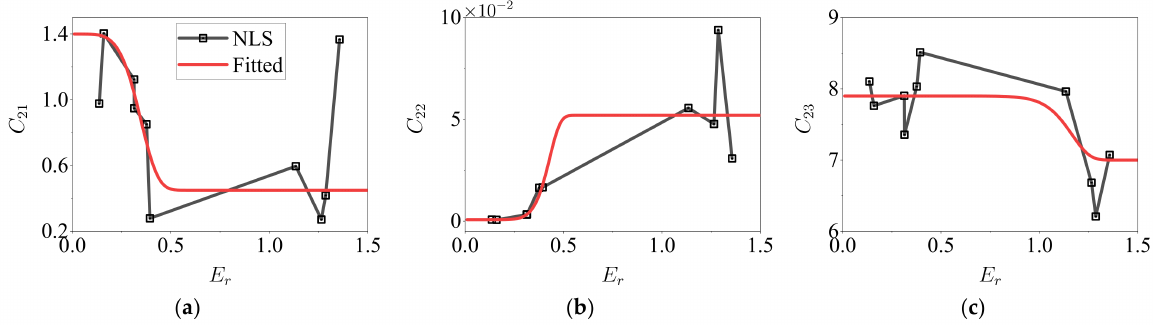
Figure 18. General parameters for β , ( a ) C 21 , ( b ) C 22 , ( c ) C 23